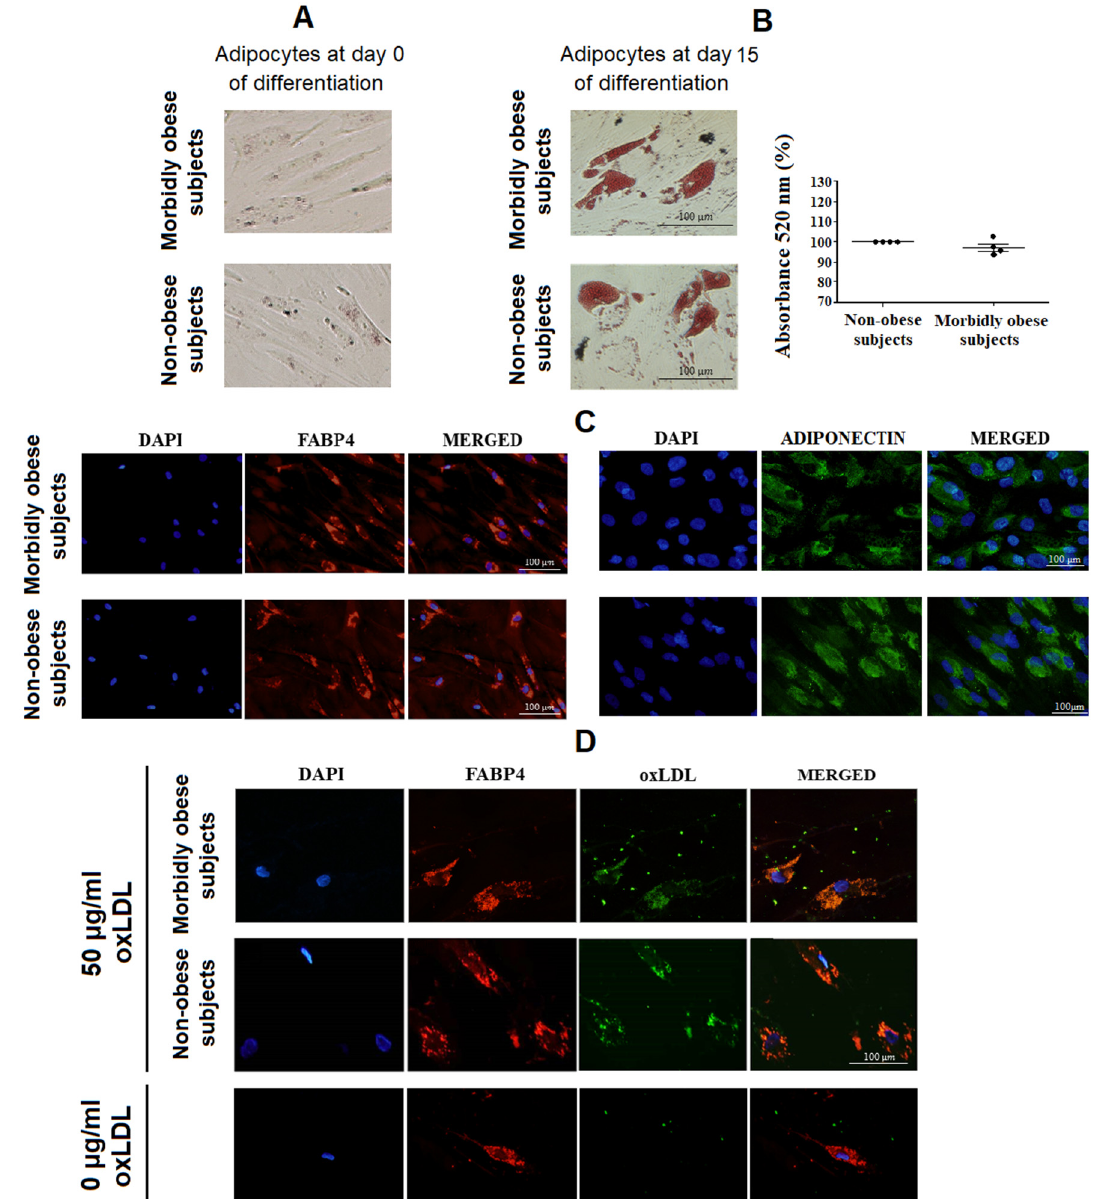
Figure 1. ( A ) Oil red-O staining of human mesenchymal stem cells at day 0 of differentiation; ( B ) Oil red-O staining and quantification in human visceral in vitro differentiated adipocytes after 15 days of differentiation; ( C ) immunofluorescence staining of FABP4 and adiponectin in human visceral in vitro differentiated adipocytes after 15 days of differentiation; ( D ) OxLDL uptake by visceral in vitro differentiated adipocytes. In vitro differentiated adipocytes were incubated without oxLDL (0 μ g/mL oxLDL or negative control) and with 50 μ g/mL oxLDL for 4